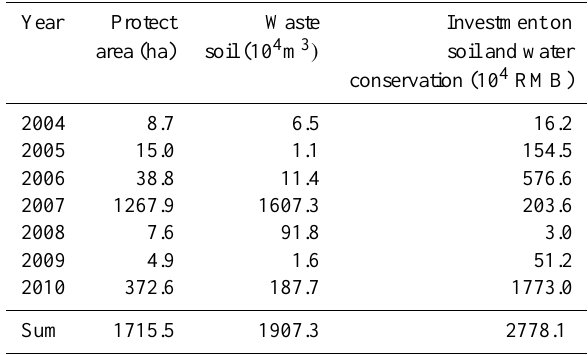
Table 9. The potential disposal of excavated soil, as well as in- vestment in soil and water conservation by construction projects (2004–2010).